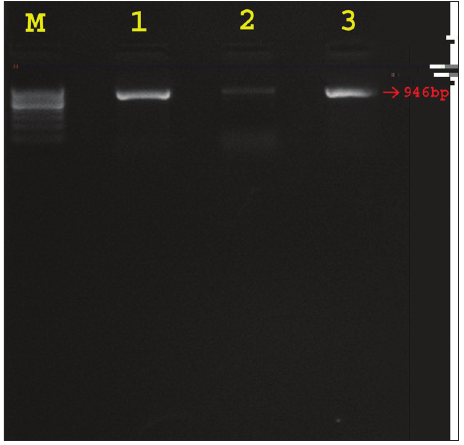
Figure-2: Agarose gel electrophoresis showing the results of polymerase chain reaction amplified product of 946 bp for the agrBD gene of Staphylococcus pseudintermedius isolates. Lane M: 100 bp DNA ladder; Lane 1, 2 and 3: agrBD gene positive for S. pseudintermedius isolates.